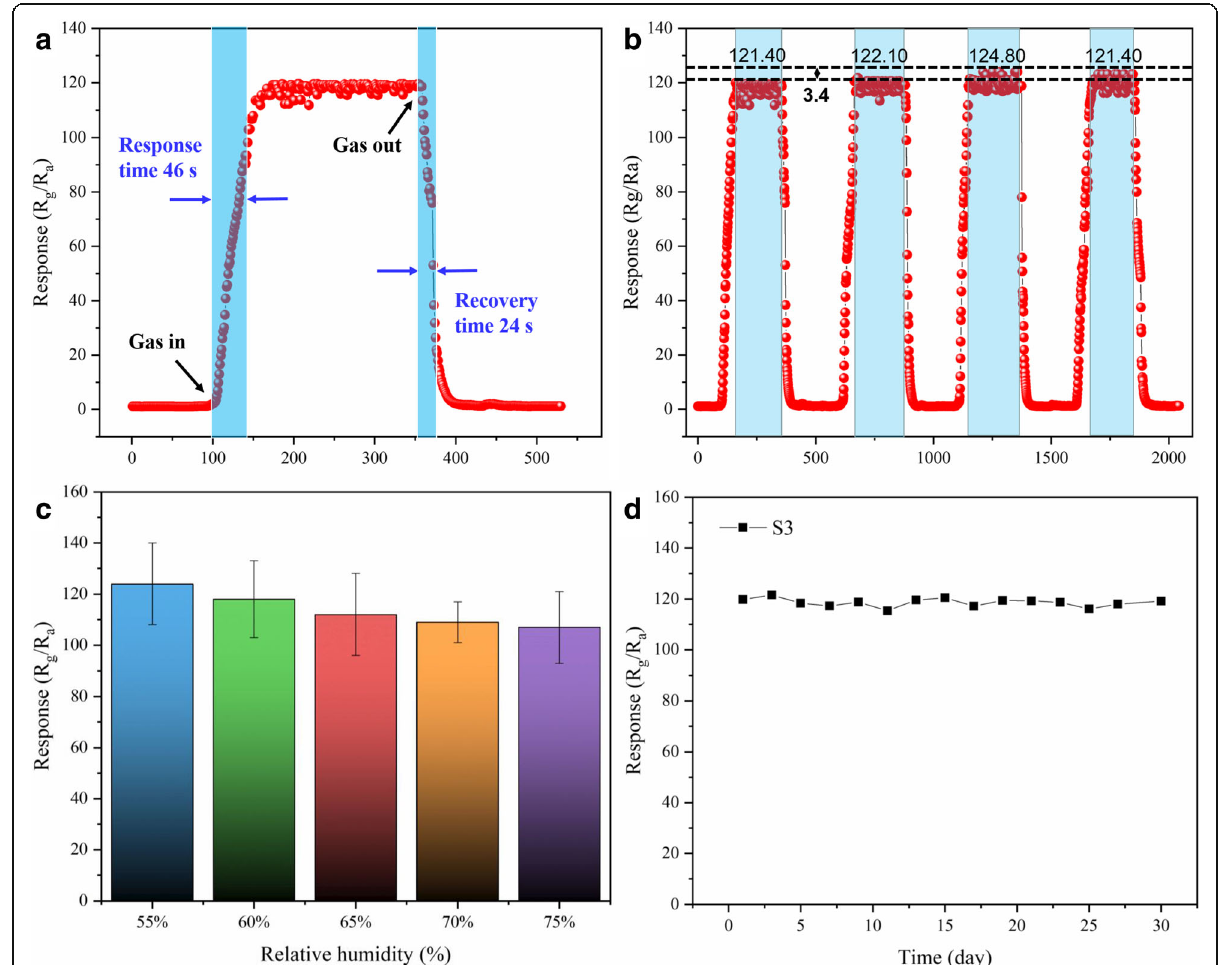
Fig. 10 a Response and recovery curve of the S3 to 5 ppm methanol gas at 195 °C. b Reversibility of S3 to 5 ppm methanol gas at 195 °C under 4 cycles. c The relationship between response and relative humidity to 5 ppm methanol gas of S3. d Stability of S3 toward 5 ppm methanol gas for 30 days at 195 °C